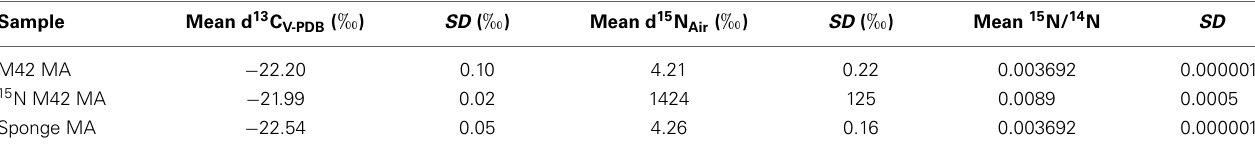
Table 1 | Analysis of 15 N Incorporation by EA-IRMS of 15 N-labeled tryptamine by M42 to produce 15 N labeled manzamine A (MA).